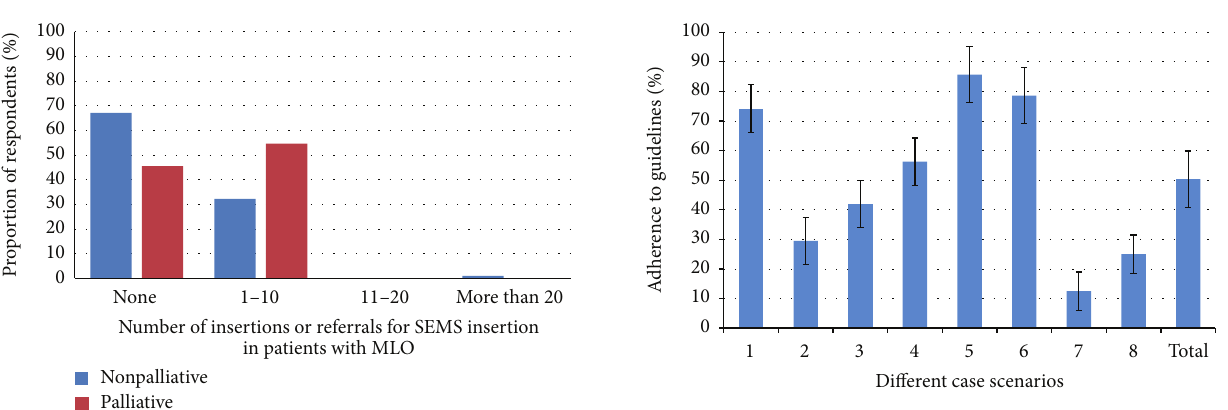
Figure 2: This figure shows the adherence of respondents to recently published guidelines (European and American Societies of Gastrointestinal Endoscopy, 2014), assessing the indications of colorectal stents in the management of acute malignant large bowel obstruction. Eight clinical scenarios were formulated as shown in Box 1. Participants could choose from four therapeutic options (as described below), one of which was deemed to be in keeping with guidelines. A pooled analysis was performed taking into account all case scenarios, yielding an overall rate of adherence of